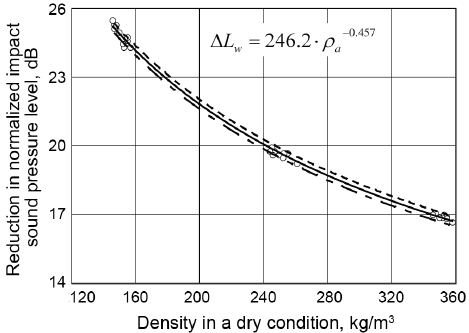
Fig. 8. The relationship between reduction in normalised impact sound pressure level and density of lightweight composite: ○ – experimental data; (——) – regression line; (- - - -) – projected minimal and maximal